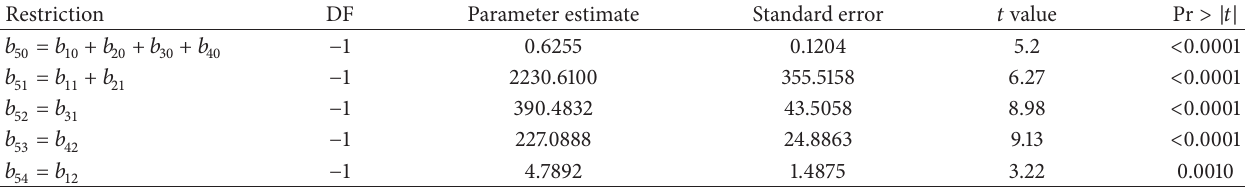
Table 9: 𝑡 -test for the restriction imposed for weighted SUR. Restriction DF Parameter estimate Standard